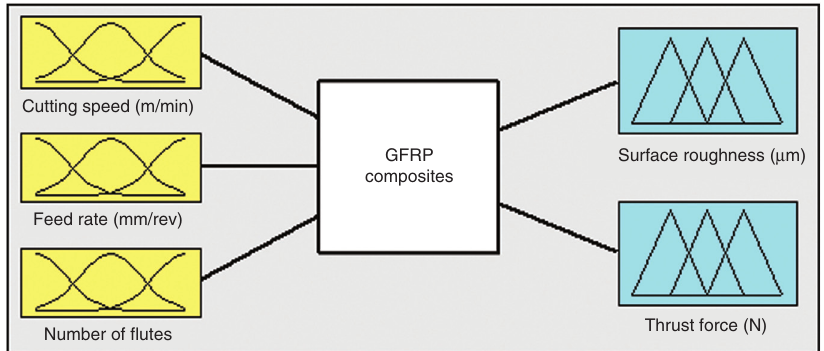
Figure 4 Fuzzy logic model